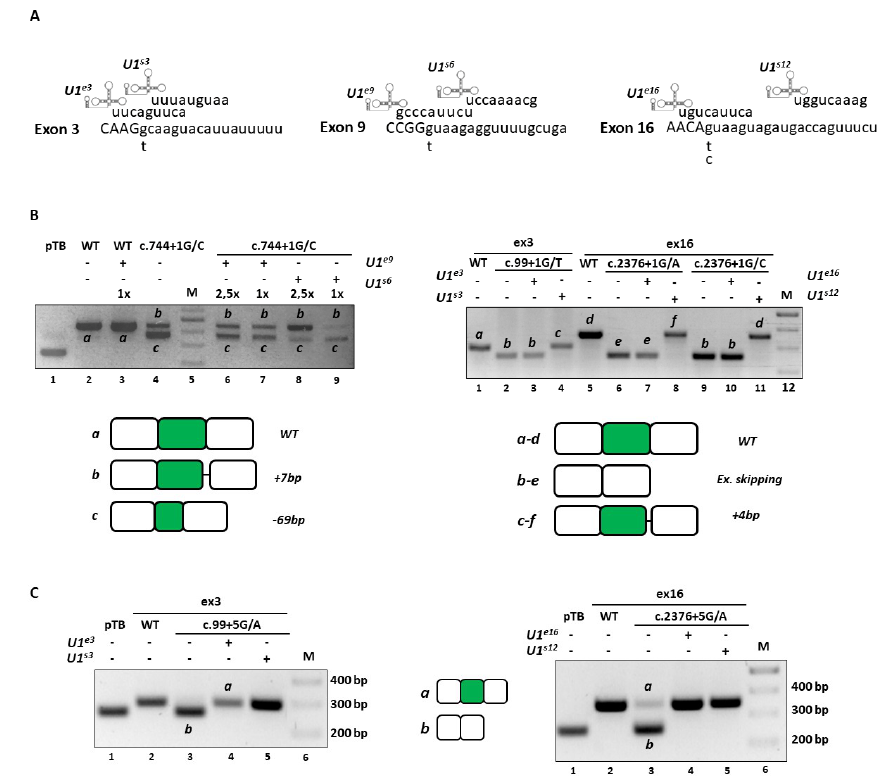
Figure 4. U1snRNA-mediated rescue of CDKL5 splicing variants at position + 1 and + 5 of 5 (cid:48)